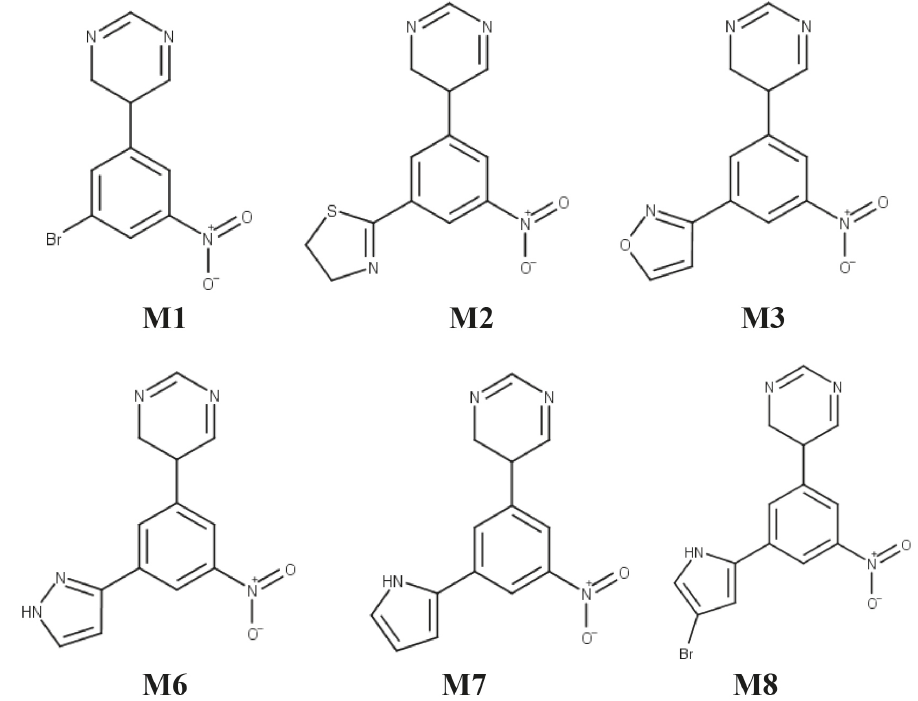
FIGURE 24 - Molecules considered favorable in relation to fragments for anti-PC activity.